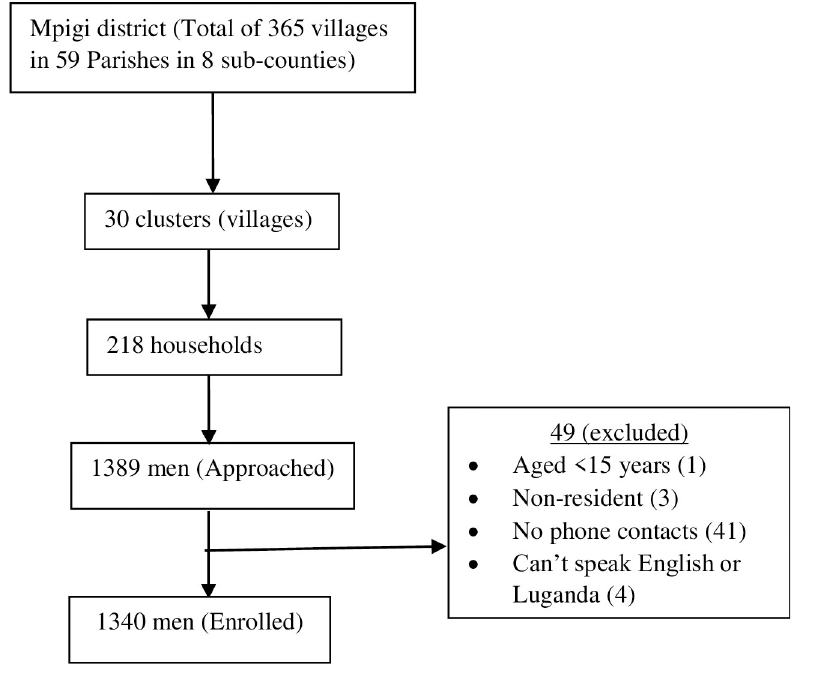
Fig 1. Profile showing enrolment of the survey